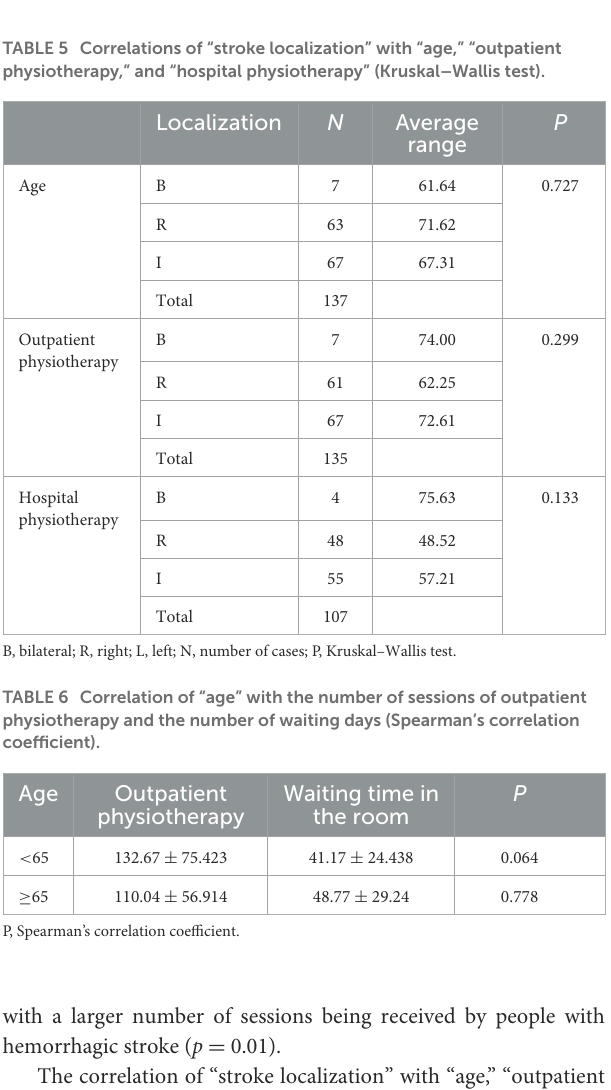
TABLE 4 Correlation between the type of stroke and the different hospital physiotherapy variables (Mann–Whitney U -test). Type of stroke